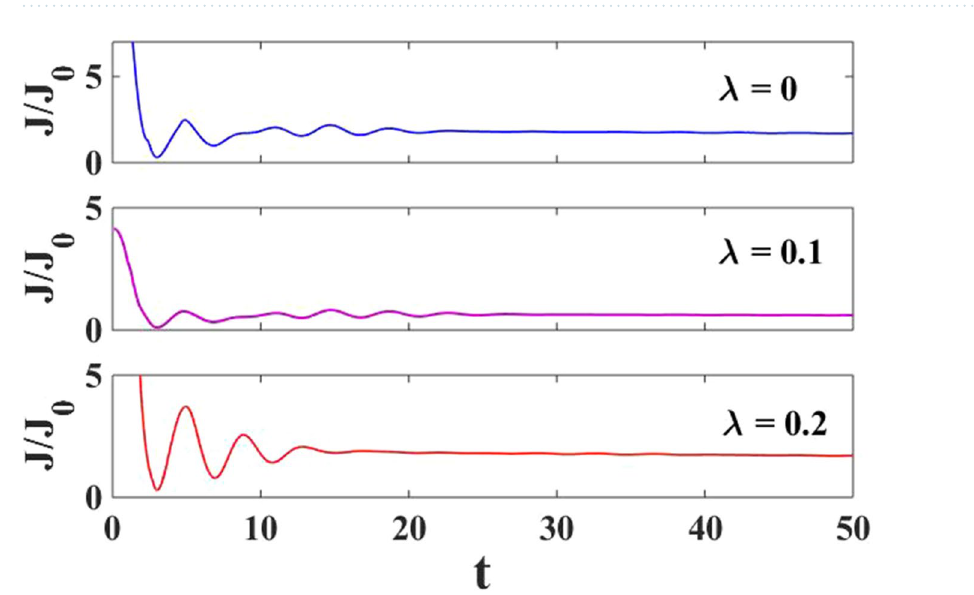
Figure 3. J / J 0 versus t for various values of (cid:31) at eV g = 0.6